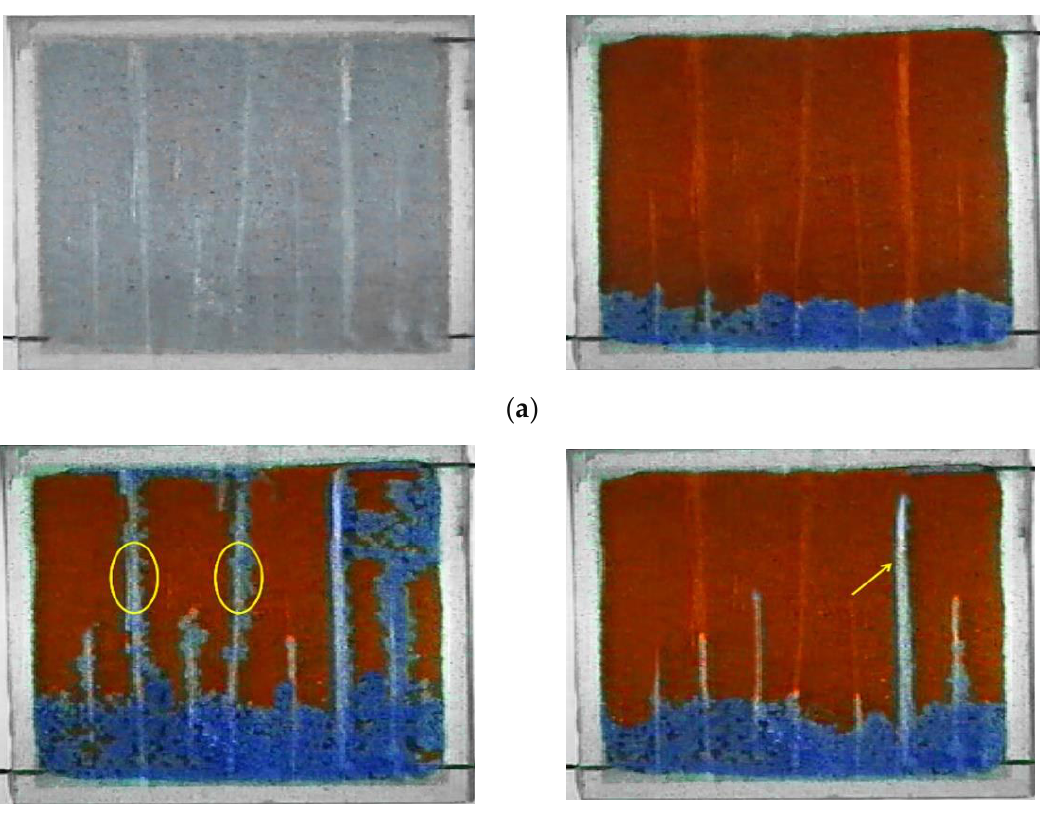
( b ) (the yellow circle and the arrow represents water-channeling channel)